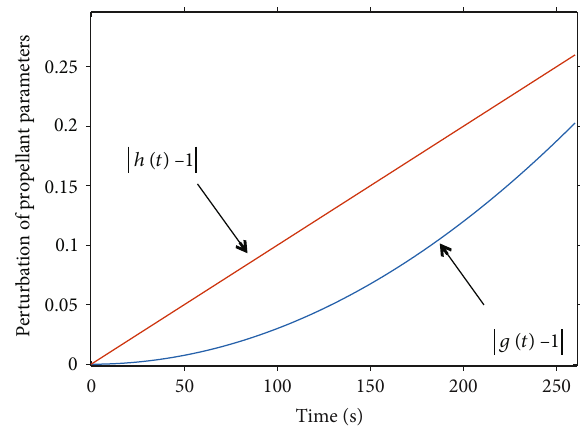
Figure 24: Perturbations of C